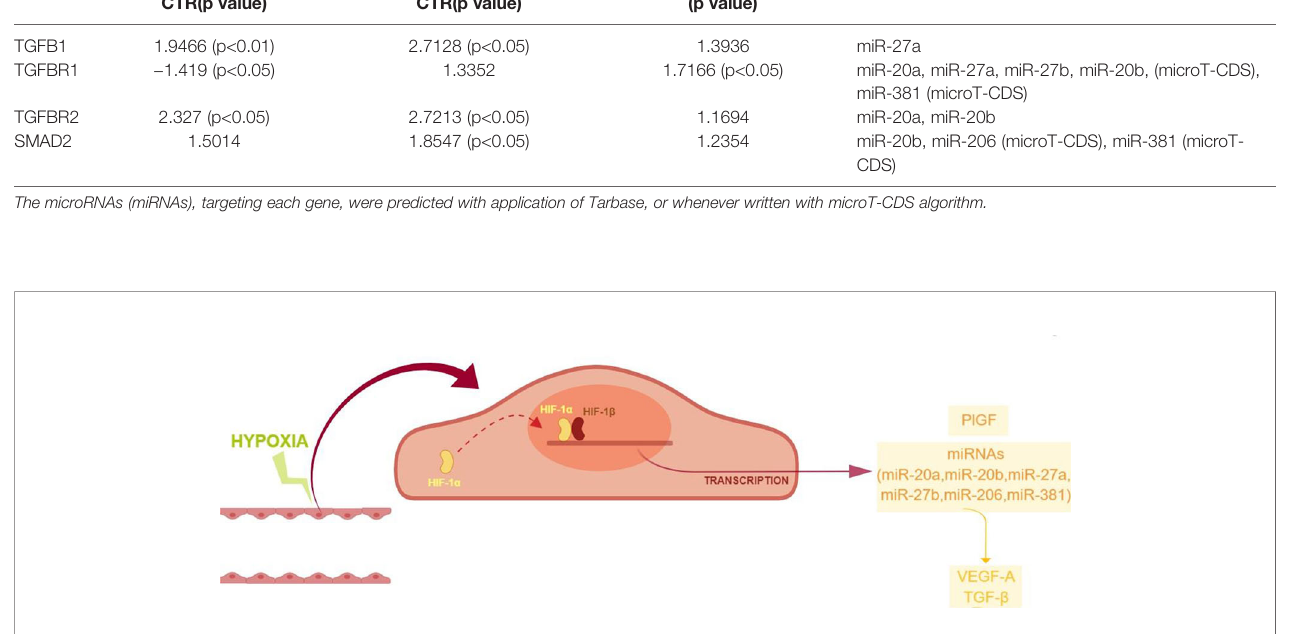
FIGURE 7 | Proposed model of angiogenic shift in retinal endothelial cells exposed to chemical hypoxia. CoCl 2 -induced hypoxia leads to the stabilization of HIF-1 a , with the subsequent translocation into the nucleus and transcription of hypoxia-related